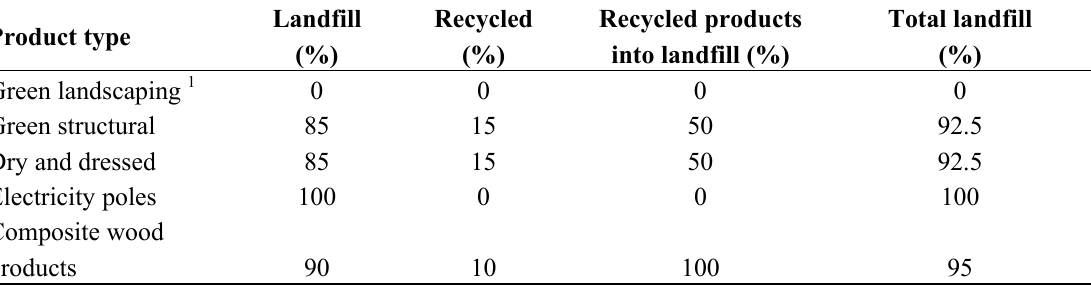
Table 5. End of life fate of harvested wood products (HWPs) from the case study forests.